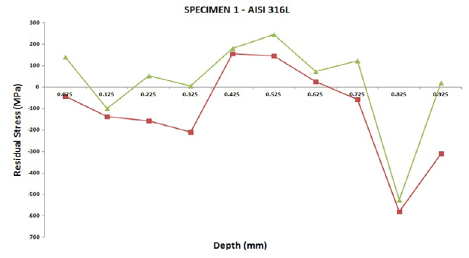
Figure 5. Distribution of the minimum and maximum residual stresses in specimen 1, contemplating the interface region between BM and HAZ of stainless steel AISI 316L.